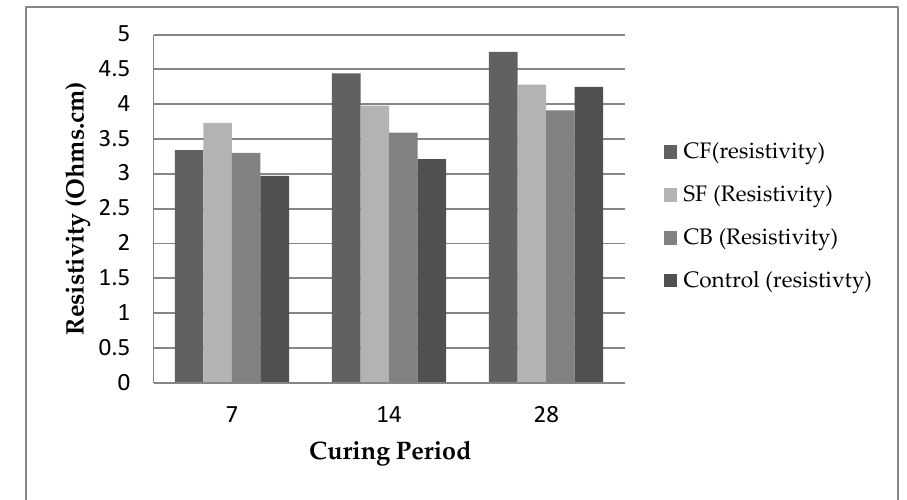
Figure 10. Curing effects for different fibres at different curing ages.